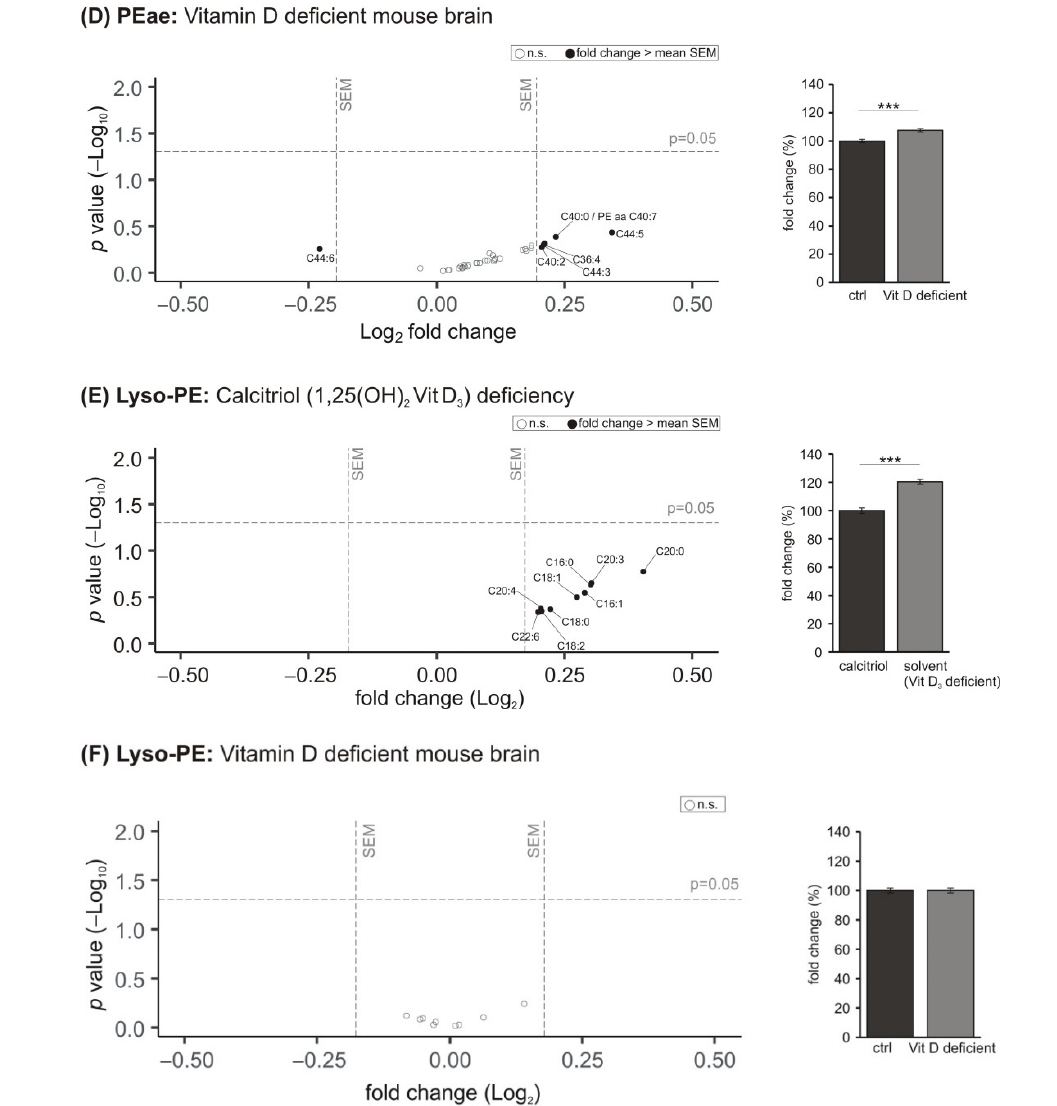
Figure 4. Effect of vitamin D 3 deficiency on phosphatidylethanolamine (PE) species. ( A ) The levels of PEaa in SH-SY5Y wt cells incubated with the solvent control (ethanol) were compared to cells treated with 1,25-dihydroxy vitamin D 3 . In the volcano plot, the fold change (x-axis) of each of the 35 analyzed PEaa species (dots) was plotted against the corresponding p -value (y-axis). The volcano plots are structured as described in detail in the legend of Figure 1. The bar chart on the right shows the relative fold change of all measured PEaa species comparing calcitriol-treated with solvent-control-treated SH-SY5Y cells. ( B ) Analyzed PEaa species in brain samples of vitamin D deficient mice compared to control-fed mice in a volcano plot and relative fold changes of all measured PEaa species in a bar chart. Besides PEaa, also levels of PEae ( C , D ) and Lyso-PE species ( E , F ) under hypovitaminosis D3 conditions were examined. Error bars represent the standard error of the mean (SEM). Statistical significance was set as *** p ≤ 0.001; n.s. not